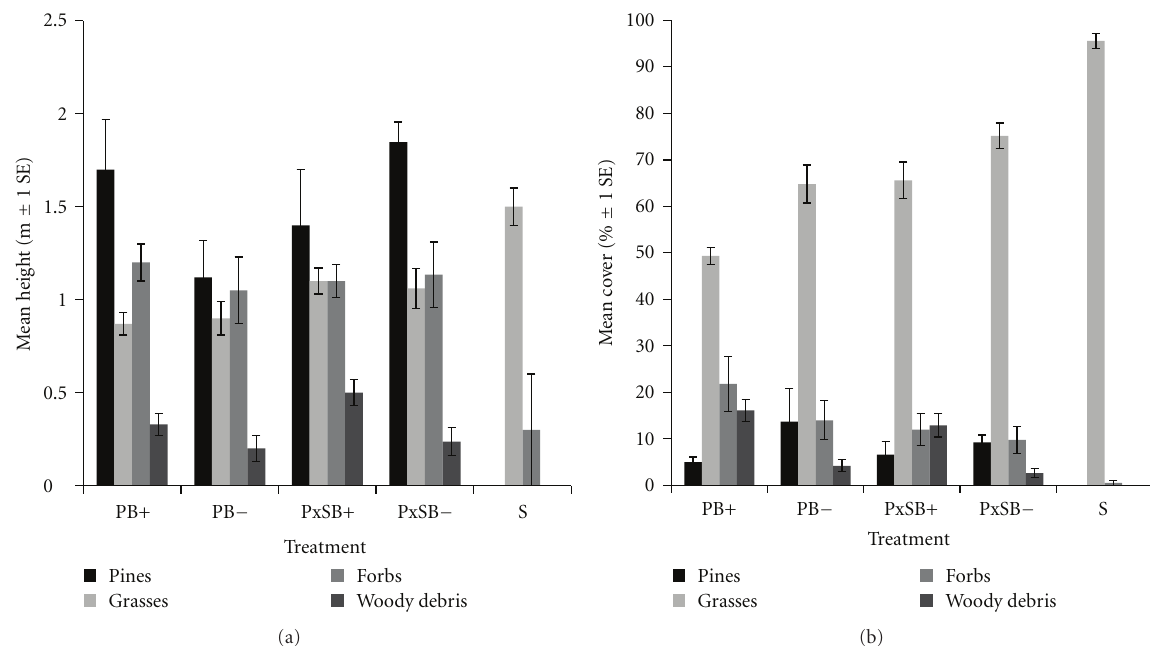
Figure 2: Mean (a) height (m; ± 1 standard error) and (b) cover (%; ± 1 standard error) of pines, grasses, forbs, and woody debris in treatment plots at the Lenoir 1 Sustainability Study Site, in Lenoir Co, NC. Mean percent cover and mean height represent the mean value of four replicate plots based on measurements taken in October 2010. Treatments: PB+ = Pine Biomass+; PB − = Pine Biomass − ; P × SB+ = Pine × Switchgrass Biomass+; P × SB − = Pine × Switchgrass Biomass − ; S =